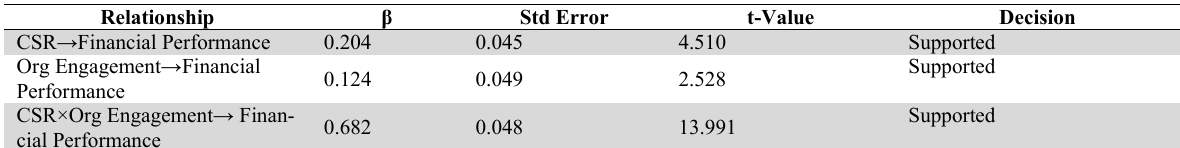
Structural Model Results